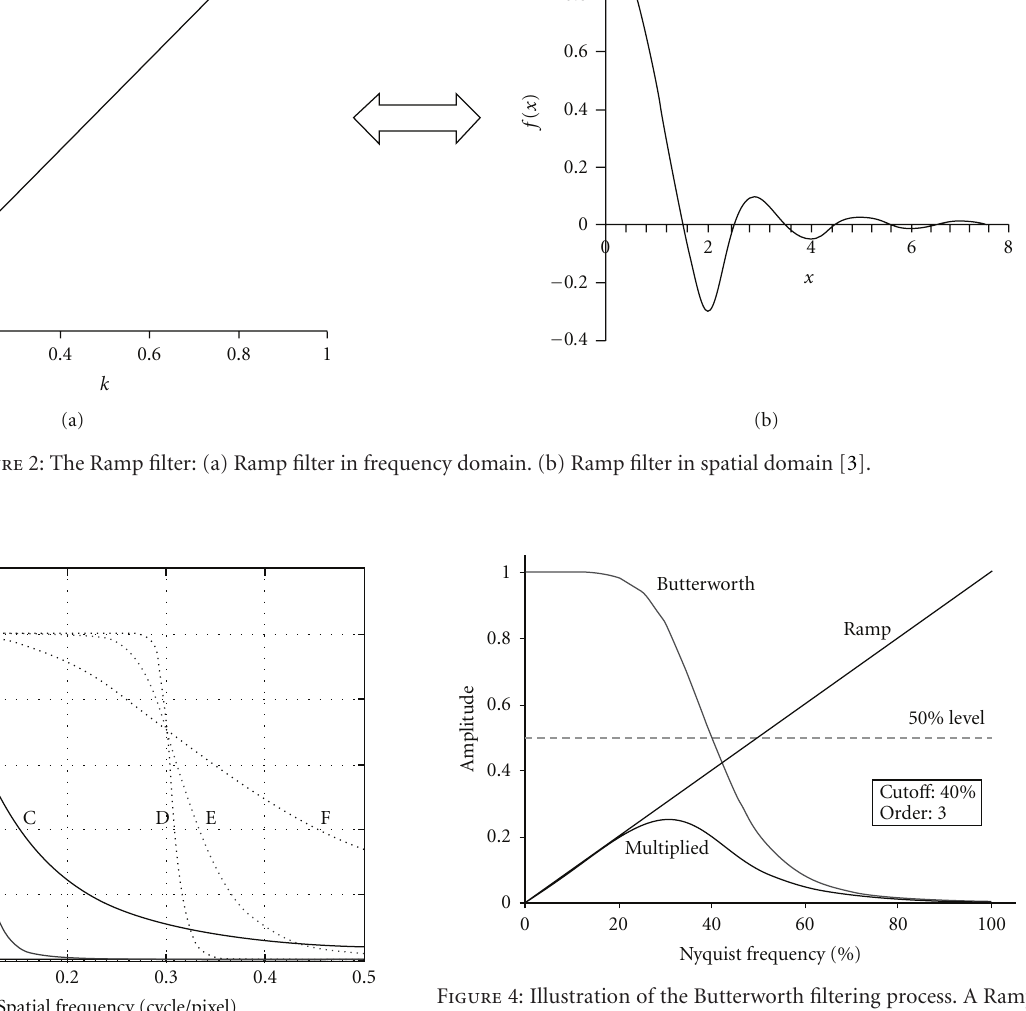
Figure 4: Illustration of the Butterworth filtering process. A Ramp function and a Butterworth function (of Order 3 and cut-o ff frequency 40% of Nq frequency) are multiplied to form the Fourier filter used in the FBP process. Generated by Kieran Maher, 2006, accessed in http://en.wikibooks.org/wiki/File:NM16 14.gif. a single parameter to describe its shape, the cut-o ff